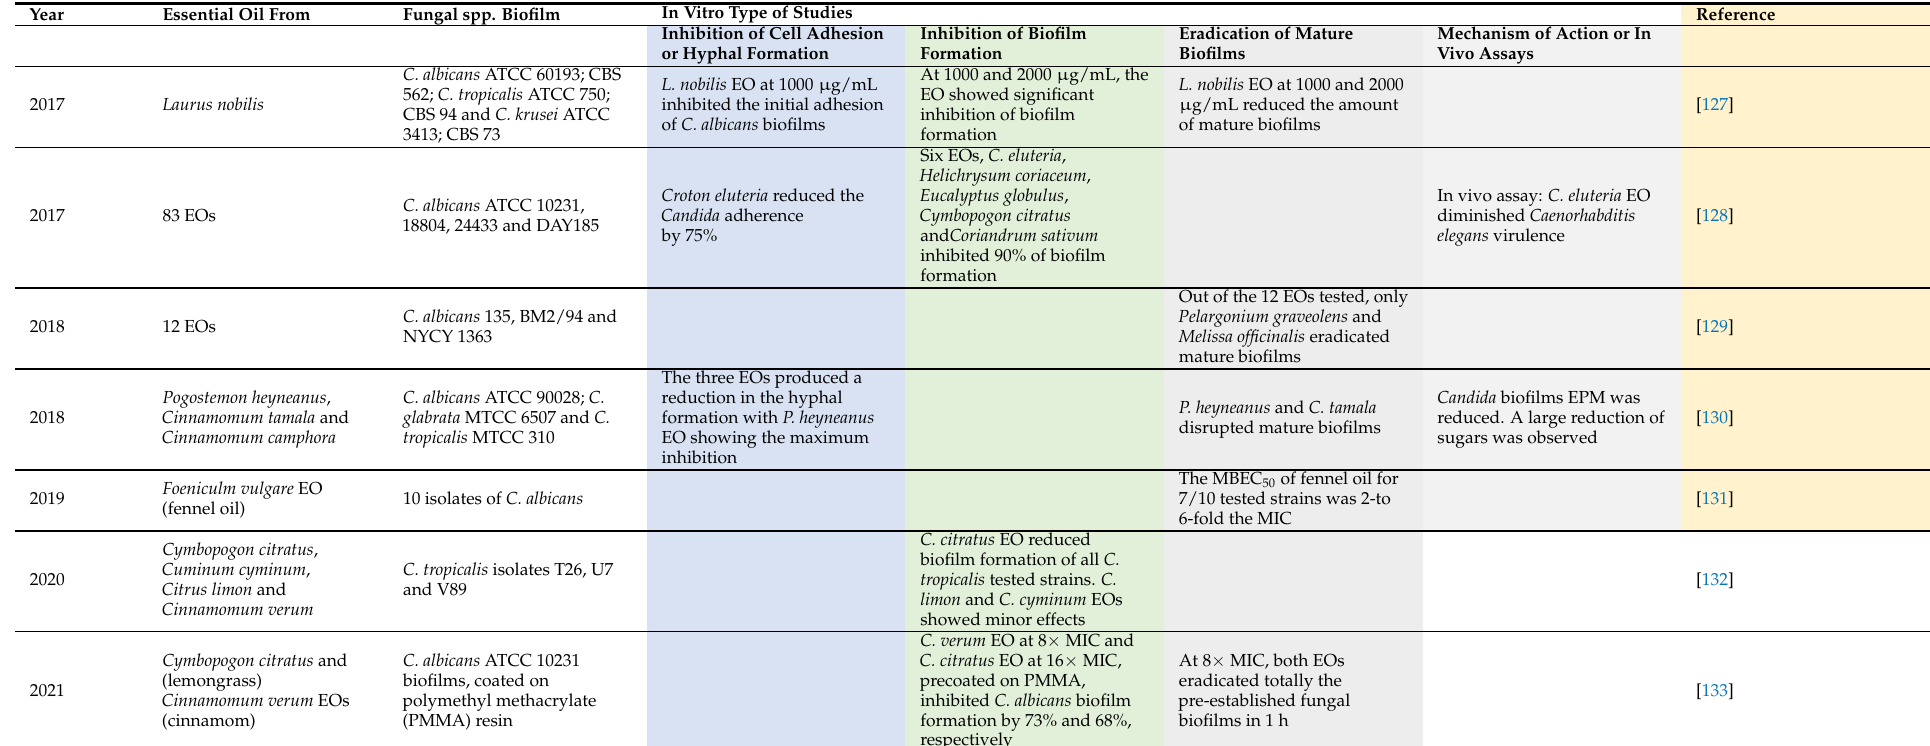
Table 1. More relevant results of essential oils (EOs) showing a capacity for inhibiting fungal